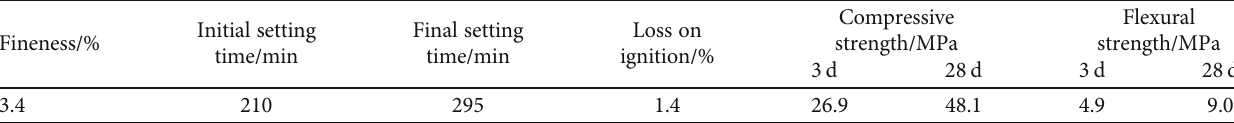
Table 2: Basic physical and mechanical indexes of cement.